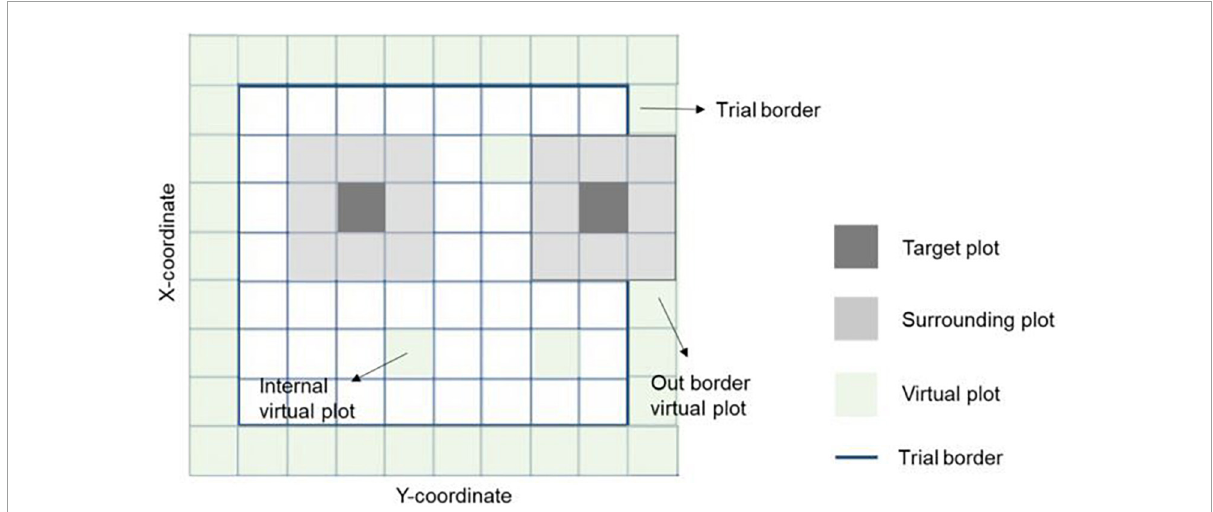
FIGURE2 Representation of spatial information in a field trial. The target and eight surrounding plots were used together to correct the spatial variability across the field. The trial borders’ effect was considered by adding virtual plots to complete the eight surrounding plots for all observations. Virtual plots were also added in empty X-Y coordinates (with no plot observation registered) to ensure all plots have the eight surrounding plots. Hence, the spatial effects on an individual plot is the sum of effects with the square centered on the plot itself plus the effects of the eight surrounding plots with a square centered on those